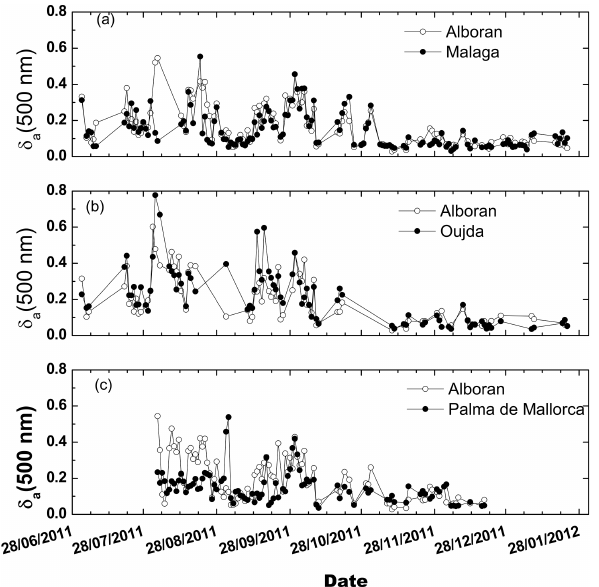
Figure 6. Temporal evolutions of daily mean values of δ a (500nm) from 1 July 2011 to 23 January 2012 obtained over (a) Alborán Is- land and Málaga, (b) Alborán Island and Oujda and (c) Alborán Is- land and Palma de Mallorca. Daily mean data were calculated only from time coincident